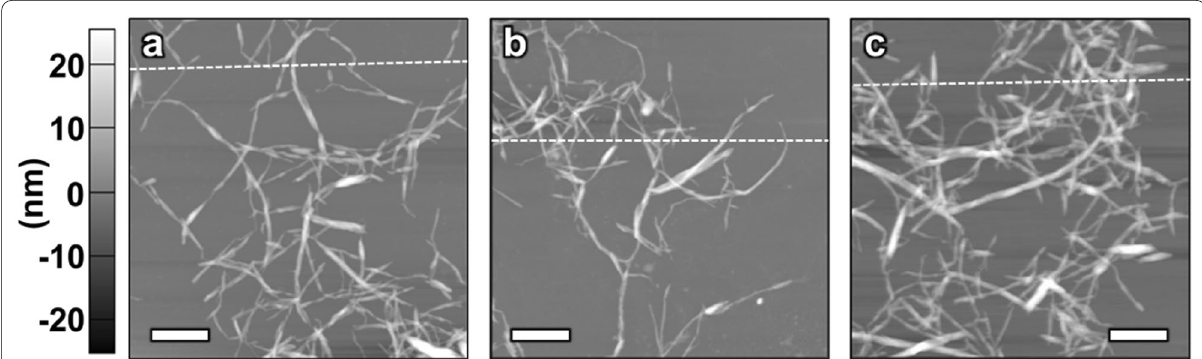
Fig. 5 AFM height images of a ACC-CNFs, b alkali-treated CNFs (7 wt% NaOH) and c CM-CNFs. Scale bar 500 nm